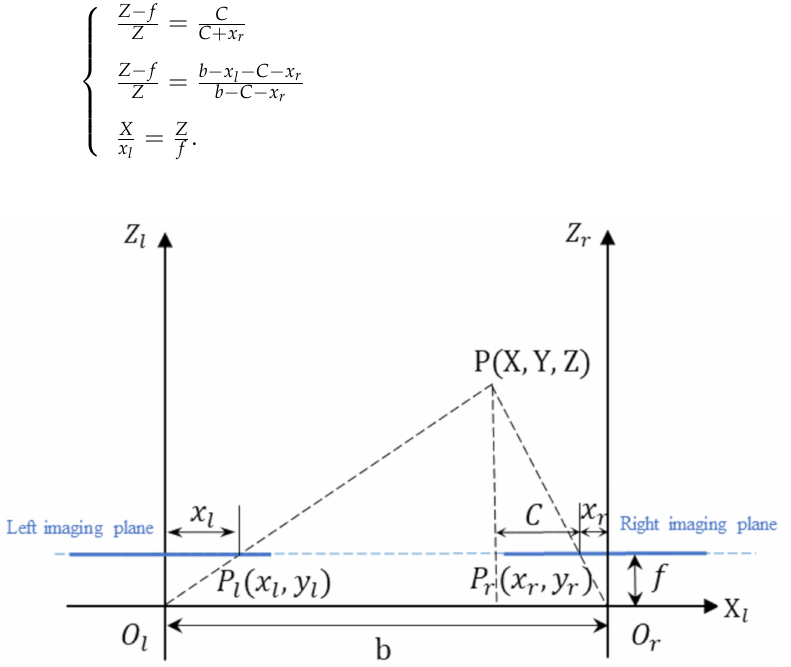
Figure 3. XOZ projection surface of the binocular stereo localization